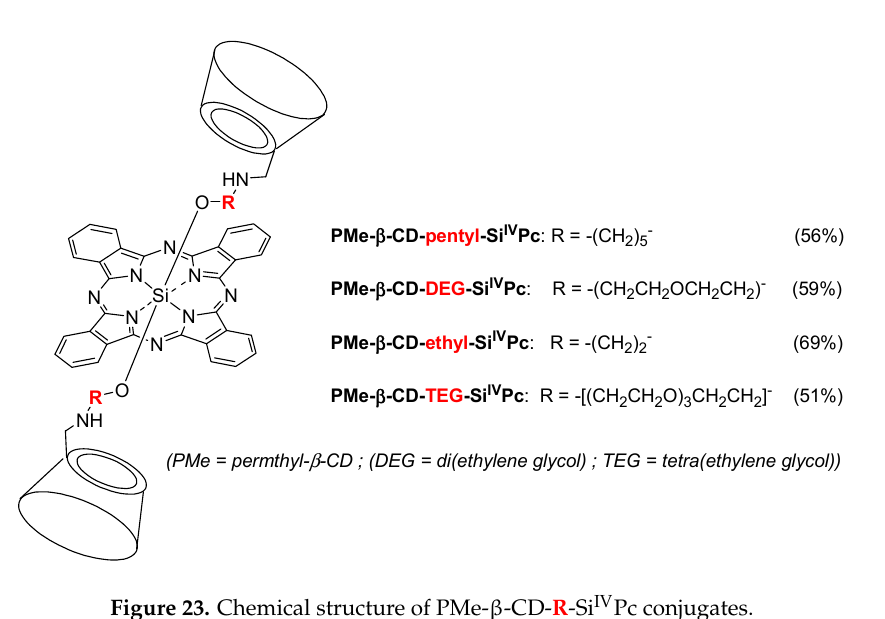
Table 4. IC 50 value comparison of all conjugates against human colon adenocarcinoma (HT29) and human hepatocarcinoma (HepG2) cells.